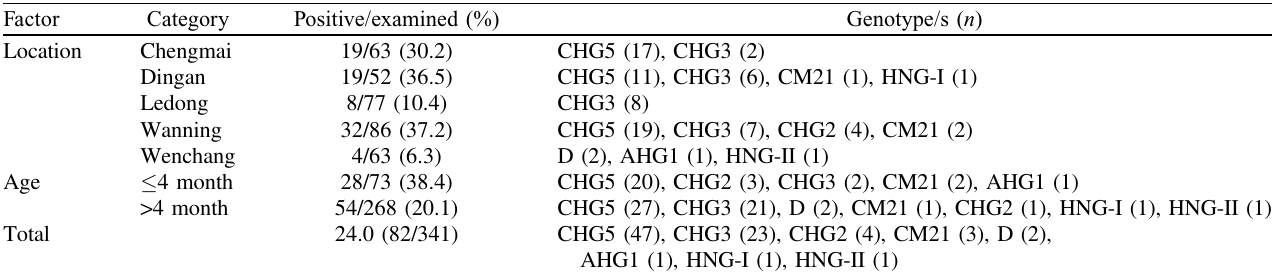
Table 1. Prevalence and genotype distribution of E. bieneusi isolates from goats farmed in different cities in Hainan